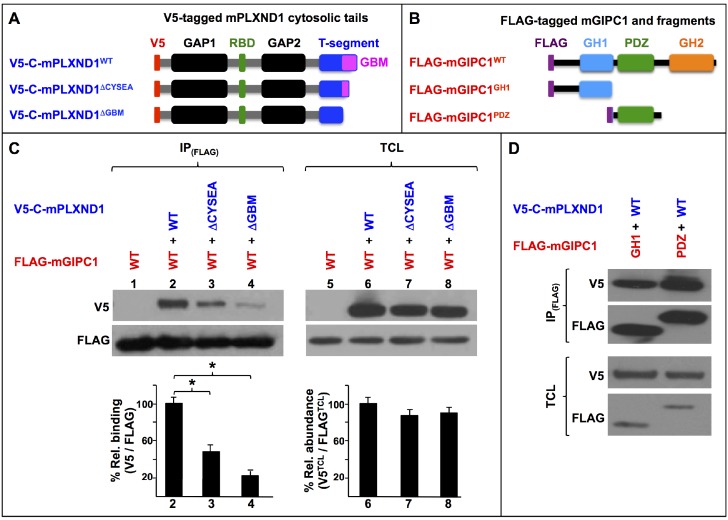
PLXND1’s C-terminal GBM and GIPC's GH1 and PDZ domains are the key molecular determinants of the PLXND1-GIPC interaction.(A) Diagrams of the wild-type (WT) and truncated V5-tagged (red) forms of the cytosolic tail of murine PLXND1 (V5-C-mPLXND1) used for co-immunoprecipitation experiments. Color-coding is used to highlight the following domains and motifs. GAP1 and GAP2 (Guanosine triphosphatase-Activating Protein domains 1 and 2; black), RBD (Rho GTPase-Binding Domain; green), T-segment (C-terminal segment, includes the GBM; blue) and, GBM (GIPC-Binding Motif; magenta); see (Gay et al., 2011). (B) Diagrams of the wild-type (WT) and truncated FLAG-tagged (purple) forms of murine GIPC1 (FLAG-mGIPC) used for co-immunoprecipitation experiments. Domains indicated as follows: PDZ (PSD-95/Dlg/ZO-1; green) and GH (GIPC Homology domain) 1 (blue) and 2 (orange); see (Katoh, 2013). (C) Western blots (top) and their quantification (bottom, bar graphs). Numbers indicate lane positions. Left-side Western blot (IPFLAG): FLAG immunoprecipitates and V5 co-immunoprecipitates showing interactions between the indicated V5-C-mPLXND1 and FLAG-mGIPC forms. Right-side Western blot (TCL), expression levels of these proteins in total cell lysates as detected with V5 and FLAG antibodies. Quantifications. n = 3 independent experiments for each protein pair. Left-side bar graph (C). Means of percentual V5/FLAG relative binding [(V5CoIP/V5TCL)/(FLAGIP/FLAGTCL)] between the indicated protein pairs from the IPFLAG Western blot (top left) and the relative abundance of the expression levels of these proteins from the TCL Western blot (top right). Error bars, ± SEM. V5/FLAG relative binding was significantly different (p<0.05) between V5-C-mPLXND1 forms and FLAG-mGIPC, F(2, 6)=22.376, p=0.002, as determined by a one-way ANOVA test. A Tukey post hoc analysis was conducted to determine whether the percentual V5/FLAG relative binding between the three tested pairs of proteins was significantly different (p<0.05; asterisks). Right-side bar graph (C). Means of percentual V5TCL/FLAGTCL relative abundance between the indicated protein pairs from the TCL Western blot (top right). Error bars, ± SEM. A Kruskal-Wallis H test was conducted to determine significant differences (p<0.05) in V5TCL/FLAGTCL relative abundance between the indicated protein pairs. Distributions of V5TCL/FLAGTCL relative abundance were not similar for all groups. The medians of V5TCL/FLAGTCL relative abundances were 92.64 (for V5-C-mPLXND1WT/FLAG-mGIPC1), 87.79 (for V5-C-mPLXND1ΔCYSEA/FLAG-mGIPC1), and 96.22 (for V5-C-mPLXND1ΔGBM/FLAG-mGIPC1), but were not statistically significantly different between them (Ramasamy et al., 2015), χ(2)=0.8, p=0.670. (D) Western blots: Top (IPFLAG), FLAG immunoprecipitates and their V5 co-immunoprecipitates showing interactions between the indicated V5-C-mPLXND1 and FLAG-mGIPC forms; bottom, (TCL) detection of the expression levels of these proteins in total cell lysates using antibodies against V5 and FLAG. n = 3 independent experiments for each protein pair. For additional data and statistical comparisons related to this figure, see Supplementary file 1, Supplementary file 2 and Supplementary file 8.